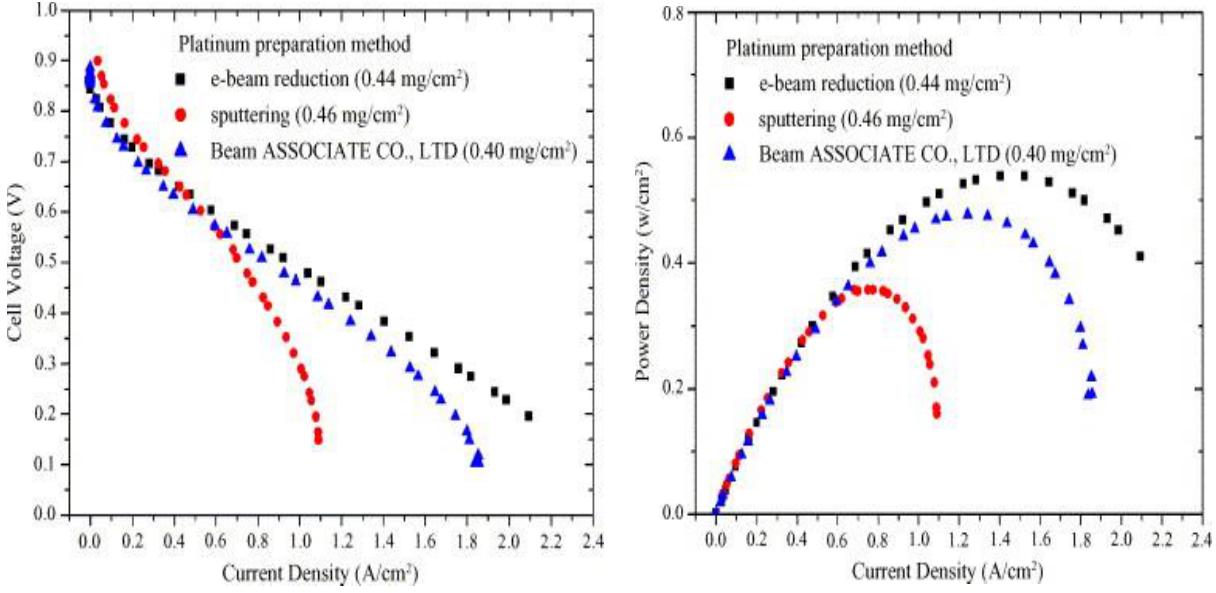
Figure 12. Polarization curves ( left ) and power density curves ( right ) with different platinum deposition techniques [193] (license no. 5172580086376).